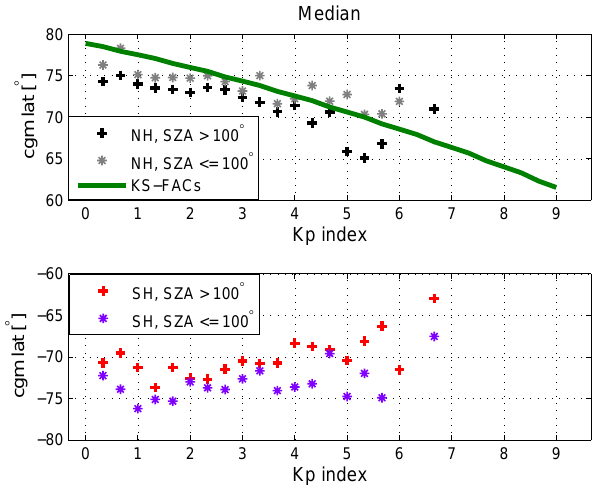
Fig. 8. Dependence of the median latitude of density anomaly peaks on the magnetic activity, K p index, for the Northern (top panel) and Southern (bottom panel) Hemisphere. The latitudes of the anomaly peaks are determined separately for two solar zenith angle ranges, where crosses are from dark and asterisks from sun- lit conditions. For comparison, the average latitude dependence of Kilometre-Scale FACs (green line) is